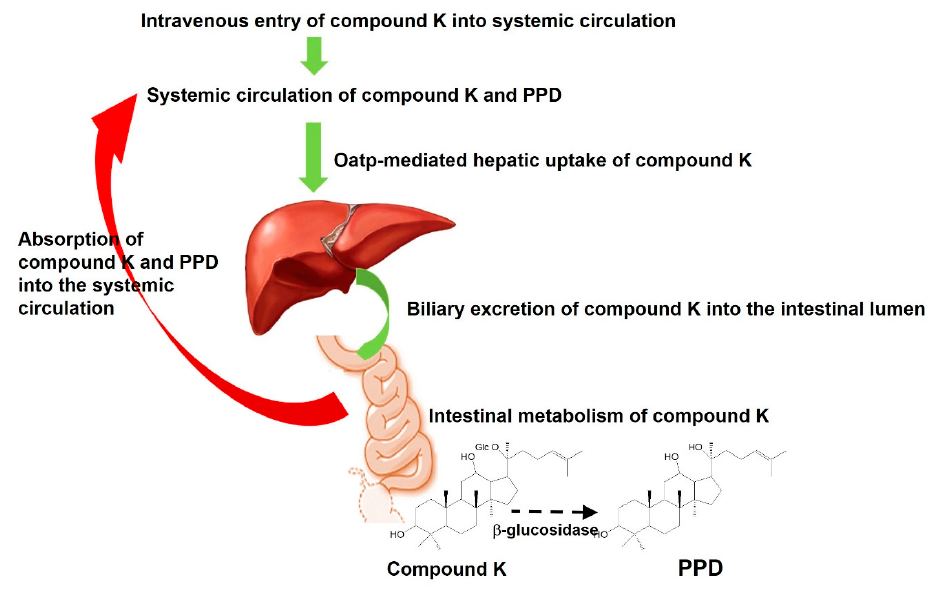
Figure 10. Proposed pharmacokinetic pathway of compound K following intravenous injection. Compound K underwent several steps: (i) intravenous entry of compound K into systemic circulation, (ii) Oatp-mediated hepatic uptake of compound K, (iii) biliary excretion of compound K into the intestinal lumen, (iv) metabolism of compound K into PPD in intestine, and (v) the absorption of compound K and PPD from intestine in blood.